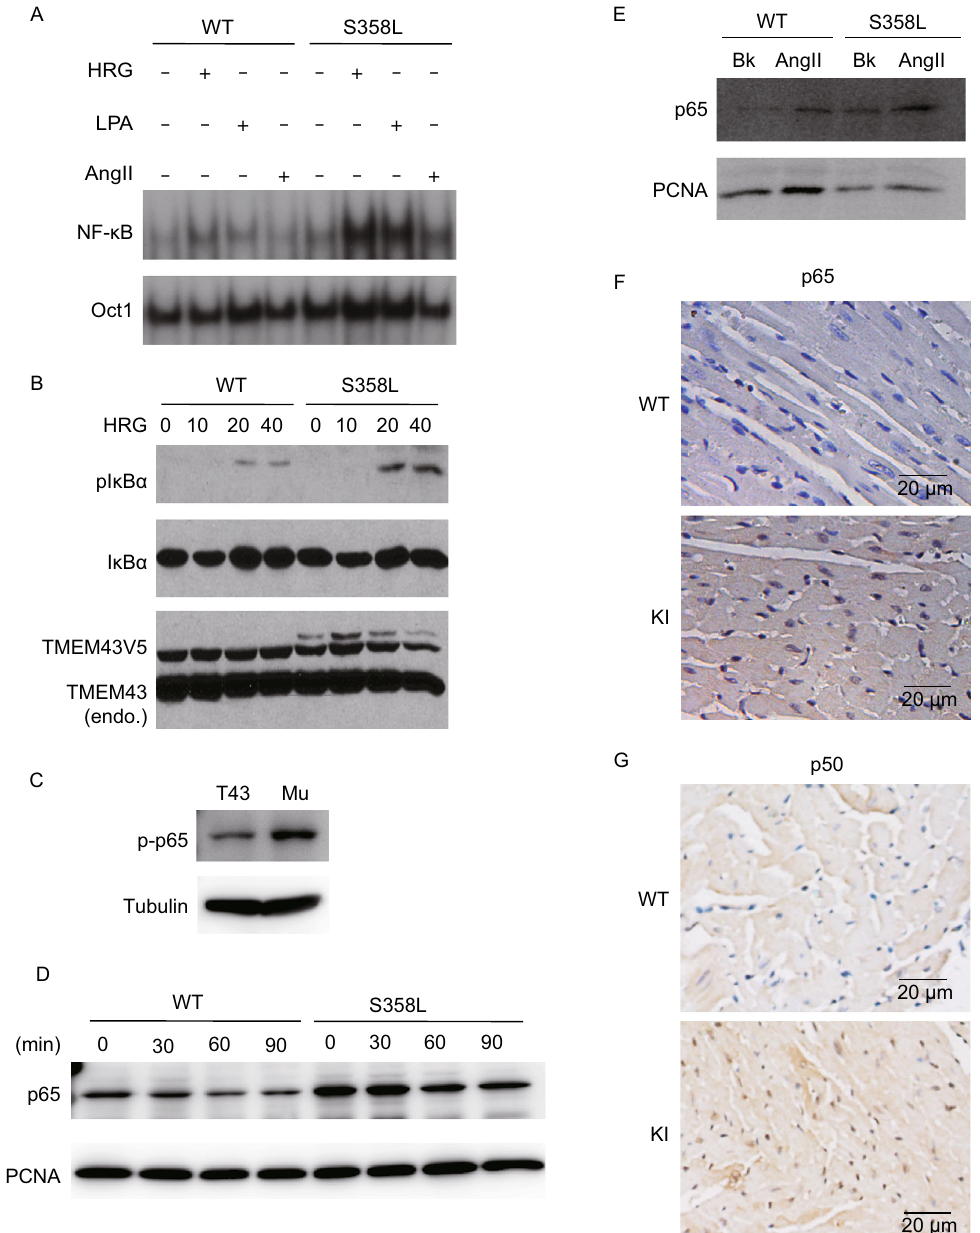
Figure 3. TMEM43 ARVD mutant enhanced NF- κ B activity. (A) Primary human cardiomyocytes stably expressing V5-tagged TMEM43WTorS358LmutantwereserumstarvedforovernightandstimulatedwithHRG(50ng/mL),LPA(10 μ mol/L)orAngII(1 μ mol/ L)for60min.NuclearextractswereisolatedandsubjectedtoEMSAanalysiswithP 32 labellednucleotideprobeofp65bindingsubstrate. OCT-1 served as a loading control. (B) Cardiomyocytes stably expressing vector or V5-tagged TMEM43 WT or S358L mutant were serum starved for overnight and stimulated with 50 ng/mL of HRG for the indicated time. The cell lysates were subjected to immunoblotting of the indicated antibodies. (C) The total protein of A549 cells stably expressing TMEM43 WTor S358L mutant were collected and lysed. The cell lysates were subjected to immunoblotting of the indicated antibodies. (D) A549 cells stably expressing TMEM43WTorS358LmutantwereserumstarvedforovernightandstimulatedwithorwithoutAngII(4 μ mol/L)fortheindicatedtime.The nuclearextracts were subjectedto immunoblotting of p65 antibodyand PCNA antibody. (E) The MEF cells derivedfrom WTand KI mice were serum starved for overnight and stimulated with or without AngII (10 μ mol/L) for 60 min. The nuclear extracts were collected and subjected to immunoblotting of p65 antibody and control PCNA antibody. (F) The paraf fi n sections of the hearts of 8-week old male WT andKImicewereperformedimmunohistologicalstainingviap65antibody.(G)Theparaf fi nsectionsoftheheartsof8-weekoldmaleWT and KI mice were performed immunohistological staining via p50